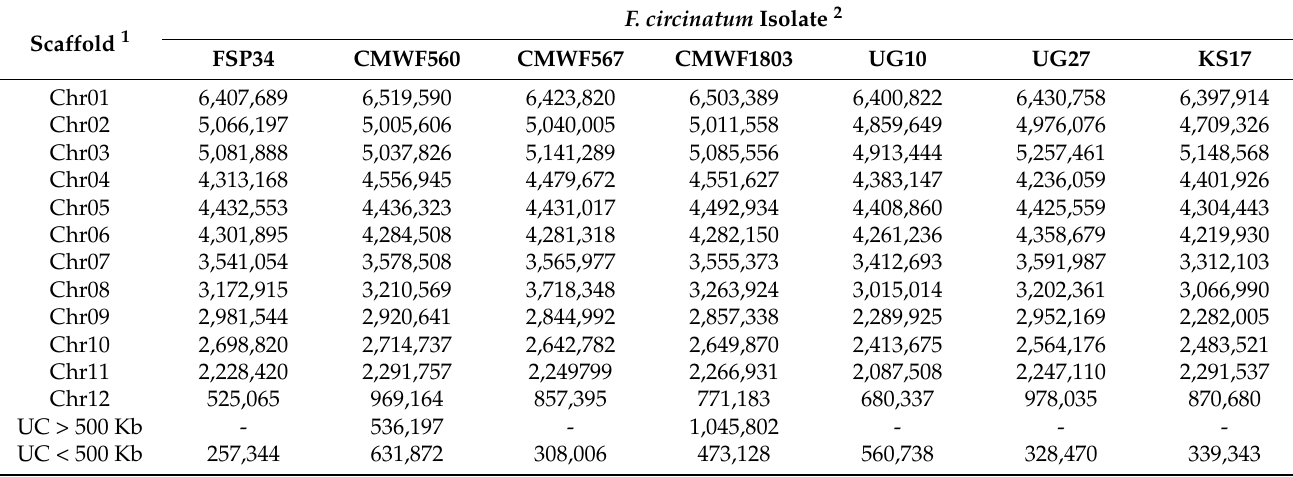
Table 2. Size of the different scaffolds in each of the assemblies for the seven Fusarium circinatum isolates used in this study.